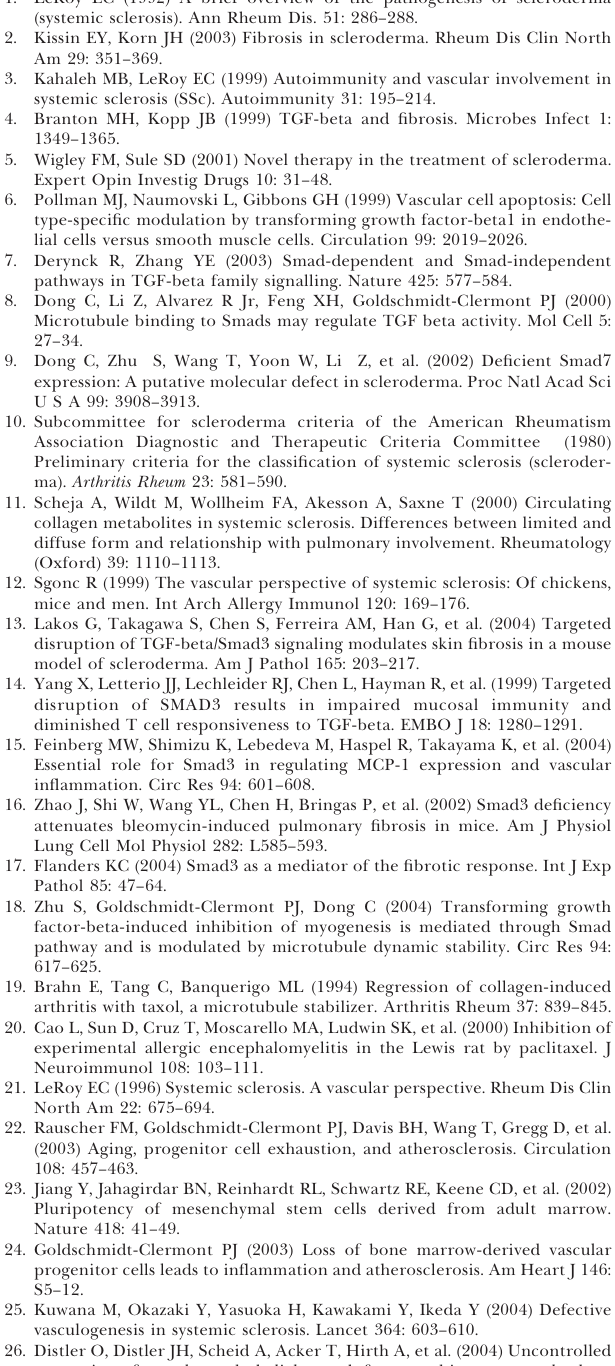
Figure S1. Paclitaxel Treatment Suppresses Smad3 Phosphorylation Strong nuclear staining for phospho-Smad3 (A) and total Smad3 (B) is observed in an SSc skin graft. Smad3 phosphorylation (C) is rare in normal graft, which also expresses a low level of total Smad3